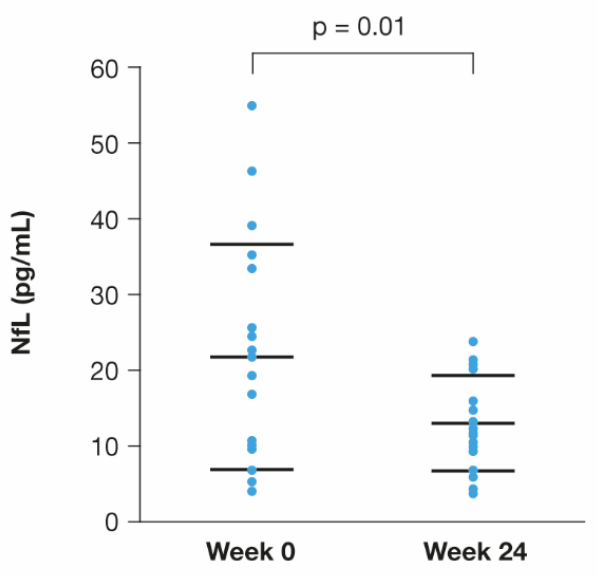
Figure 4. Changes from baseline in serum neurofilament light chain levels at 24 weeks after starting cladribine therapy in 18 patients with relapsing/remitting multiple sclerosis (Wilcoxon signed ‐ rank test).